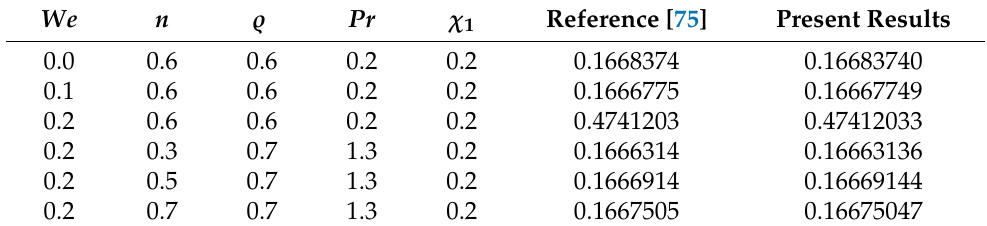
Table 2. Computation of Nu x , when Rd = Sr = M = Sc = Du = 0.